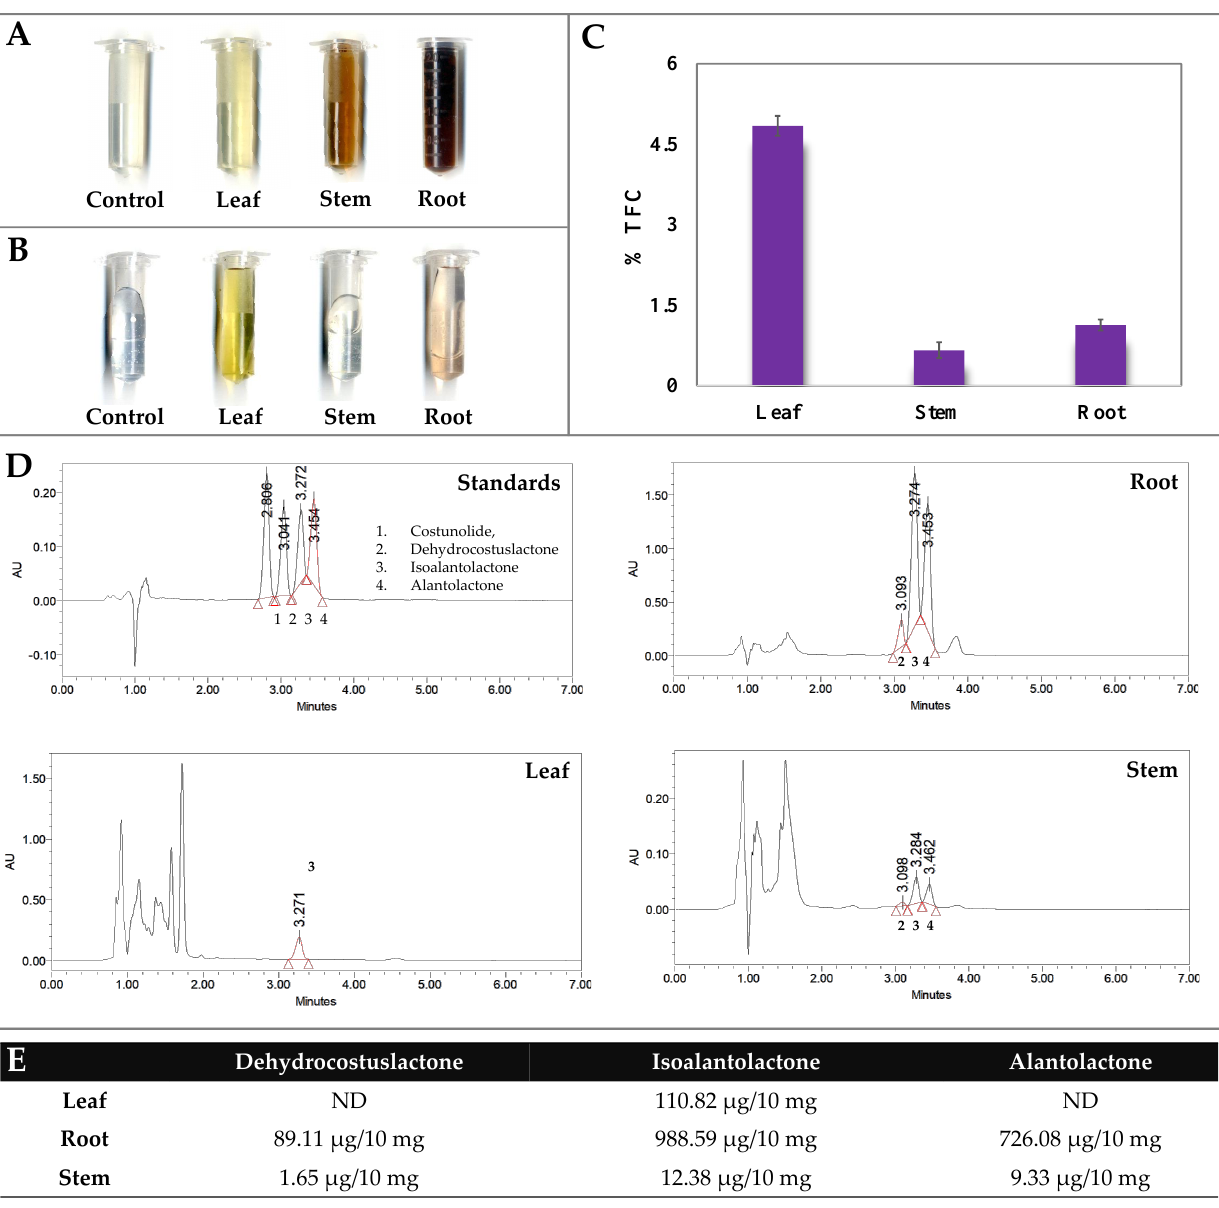
Figure 1. Phytochemical screening of leaf, stem, and root tissue of Inula racemosa . ( A ) Salkowski’s test of leaf, stem, and root tissue recorded higher accumulation of terpenoids with appearance of reddish- brown color; ( B ) alkaline reagent test recorded presence of flavonoids with appearance of yellow color in the leaf and root tissue. ( C ) Graph representing percent of total flavonoid content (TFC) with significant appearance in the leaf followed by root tissues. ( D ) Chromatogram of leaf, stem, and root extracts. The peak labelled as 1 represents costunolides; 2: dehydrocostuslactone; 3: isoalantolactone; and 4: alantolactones in the respective three tissue extracts. ( E ) Organ-specific quantification of dehydrocostuslactone, isoalantolactone; and alantolactones in leaf, root and stem